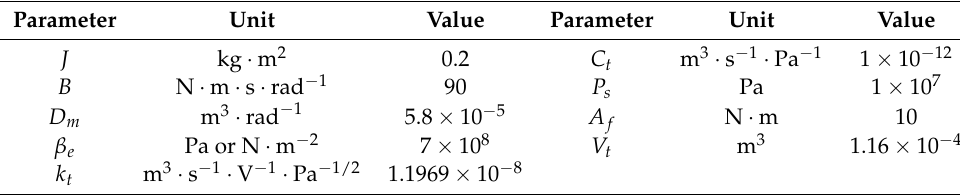
Table 1. Nominal system parameters of the studied EHS. Parameter